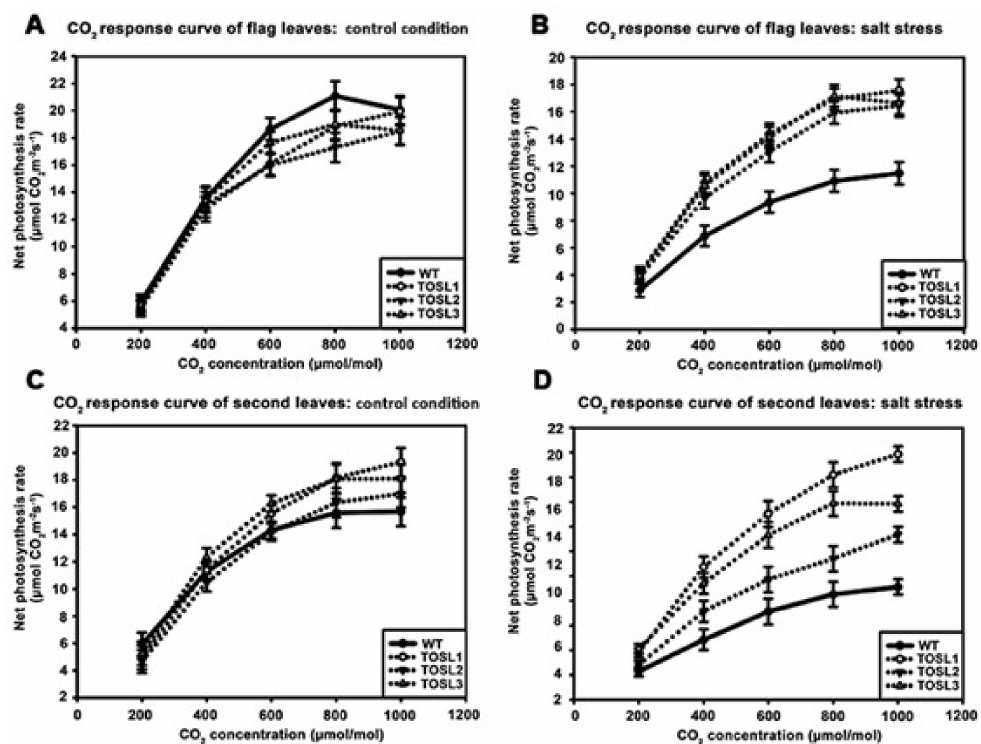
Figure 4. CO 2 -response curves of flag leaves ( A , B ) and second leaves ( C , D ), when wild type and transgenic lines, TOSL1, TOSL2, and TOSL3, were grown under control ( A , C ) and salt-stress ( B , D )